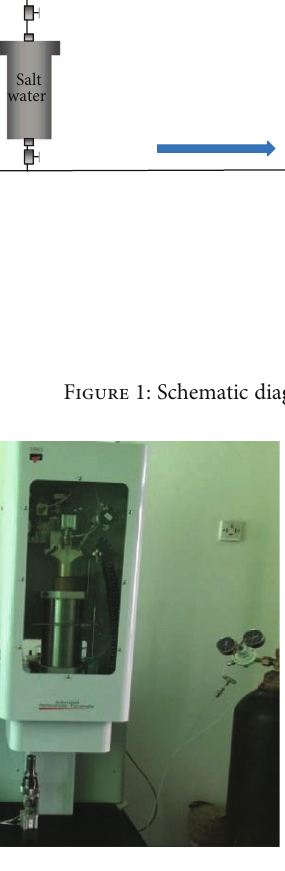
Figure 2: Overburden pressure porosity instrument.